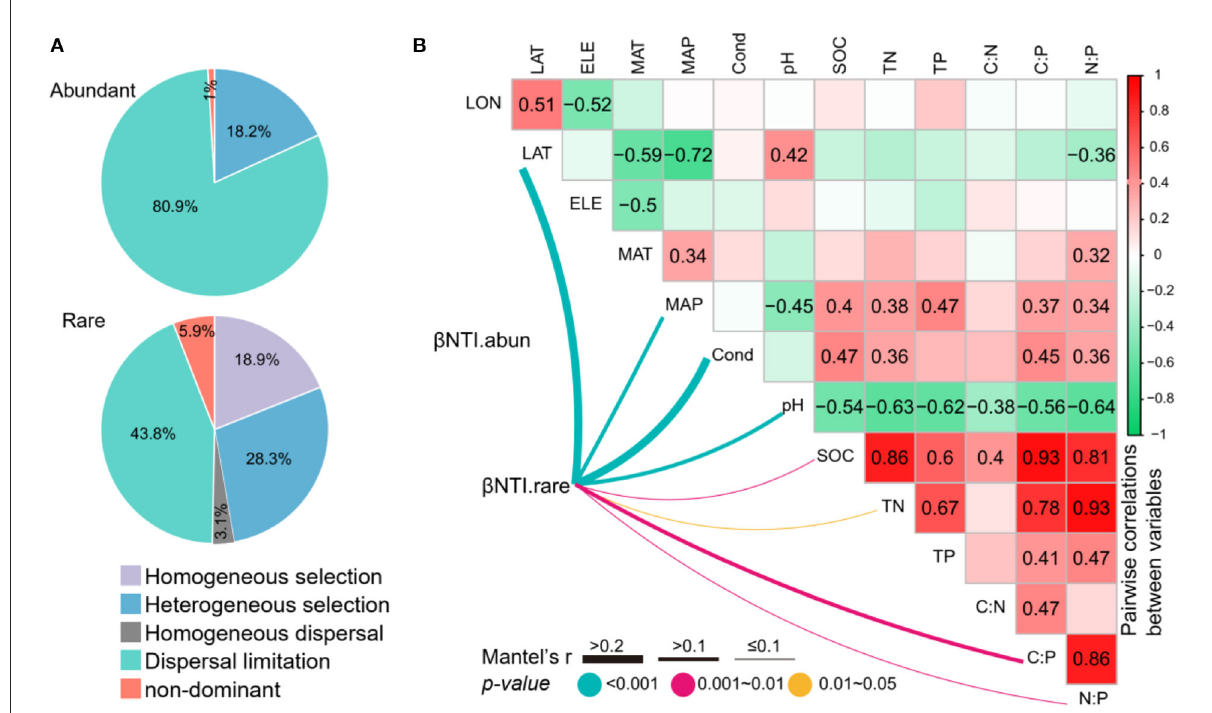
FIGURE6 (A) The contribution of deterministic (homogeneous and heterogeneous selections) and stochastic (dispersal limitations and homogenizing dispersal) processes to the assembly of abundant and rare subcommunities. (B) Pairwise correlations between environmental variables, and the Mantel tests between environmental variables vs. the beta nearest taxon index ( β NTI). The lines denote the significant relationships with line width representing the Mantel r statistic. Pairwise correlations between environmental variables are shown in the heatmap matrix denoting Pearson’s correlation coefficient. The significant results are shown in numbers. The abbreviations of the environmental variables are explained in the Methods